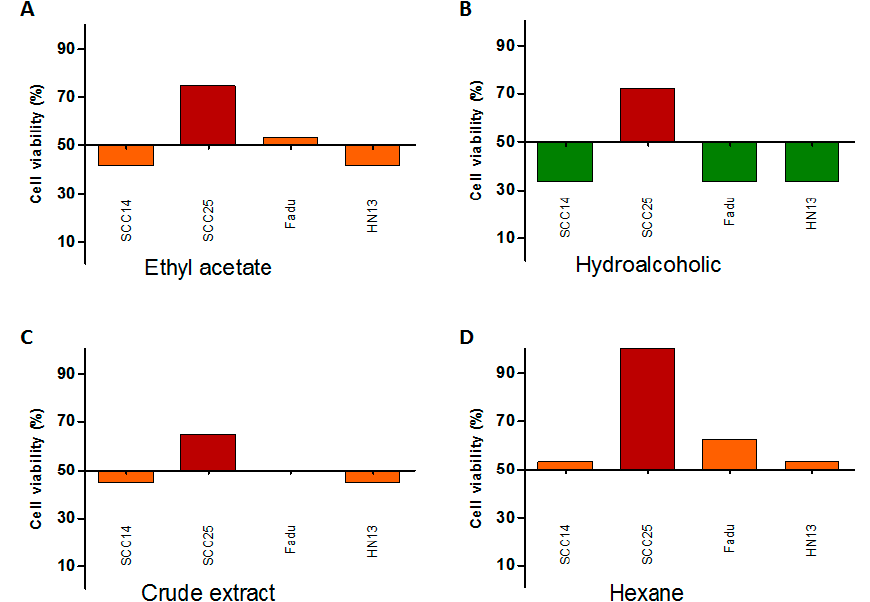
Figure 1. Cytotoxicity profile of SCC14, SCC25, Fadu, HN13 head and neck tumor cell lines, exposed to the different fractions of the T. guianensis extract: ( A ) Ethyl acetate (C1); ( B ) Hydroalcoholic (C2); ( C ) Crude extract (C3); and ( D ) Hexane (C4). Bars represent the cell viability at 50 µg/mL. Bars represent the GI score classification. Green (HS: highly sensitive); Orange (MS: moderate sensitive) and Red (R: resistant). Table 3. Growth inhibition to different fractions of the T. guianensis extract in HSCC cell lines.